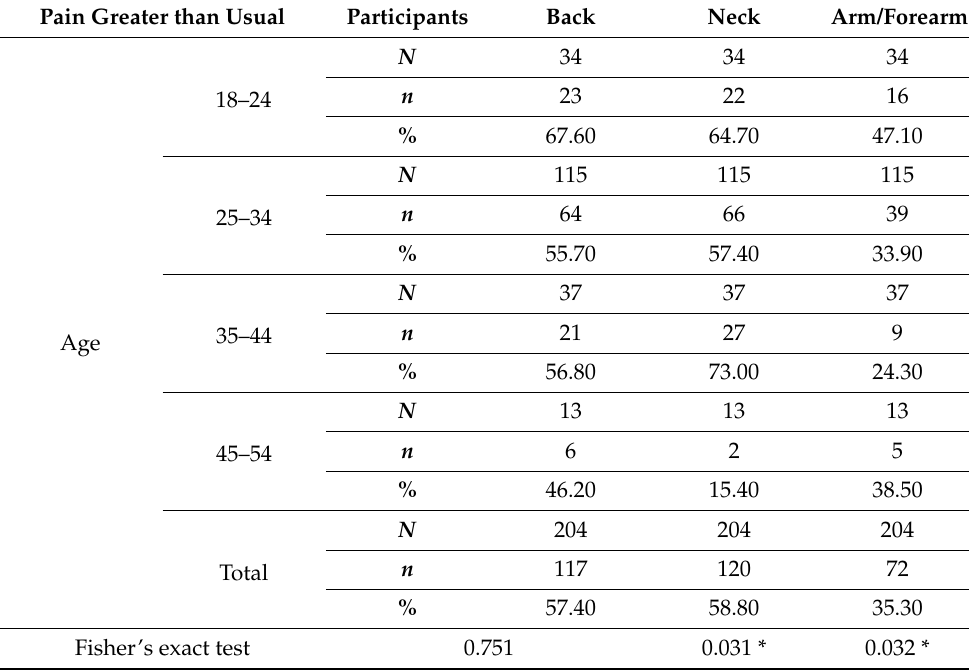
Table 2. Ailments according to the age of the respondents.